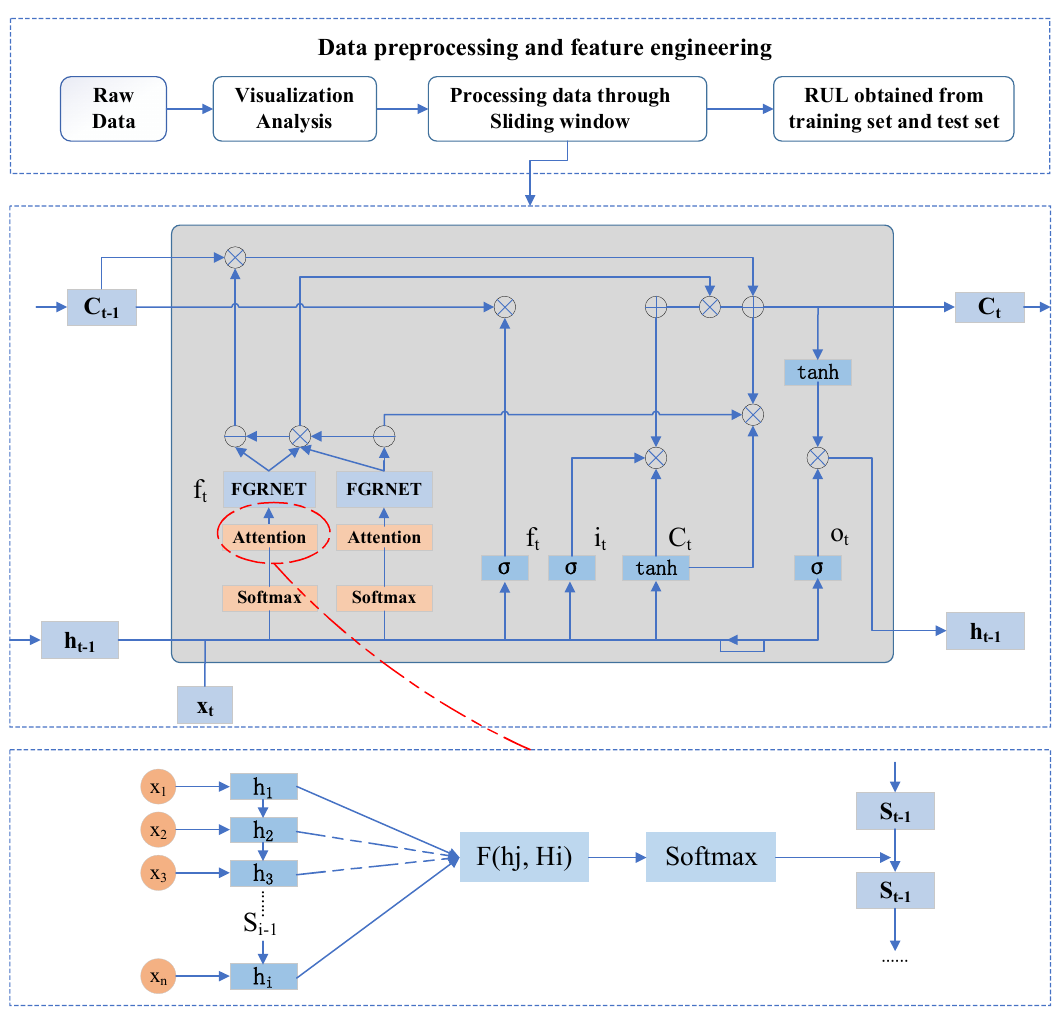
Figure 3. Flowchart of the proposed model.